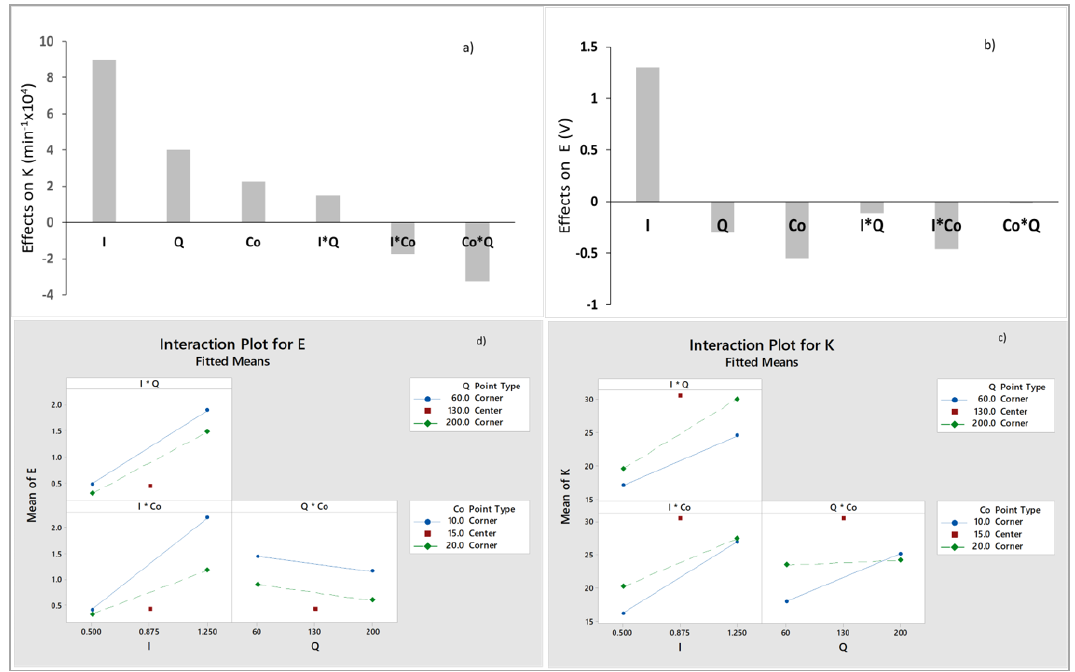
Table 1. Values of the K and E measured in the eight runs of the DoE. Averaged values and the related standard deviation (SD) are evaluated for data repeated twice.